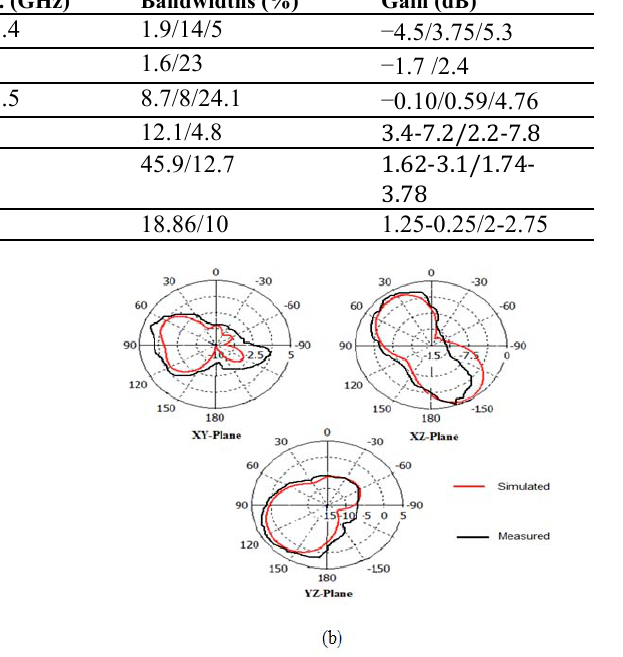
Figure 9: Measured (black) and simulated (red) far-field radiation patterns of the proposed antenna in the YZ ,XZ and XZ planes at (a) 3.5 GHz and (b) 7.8 GHz.